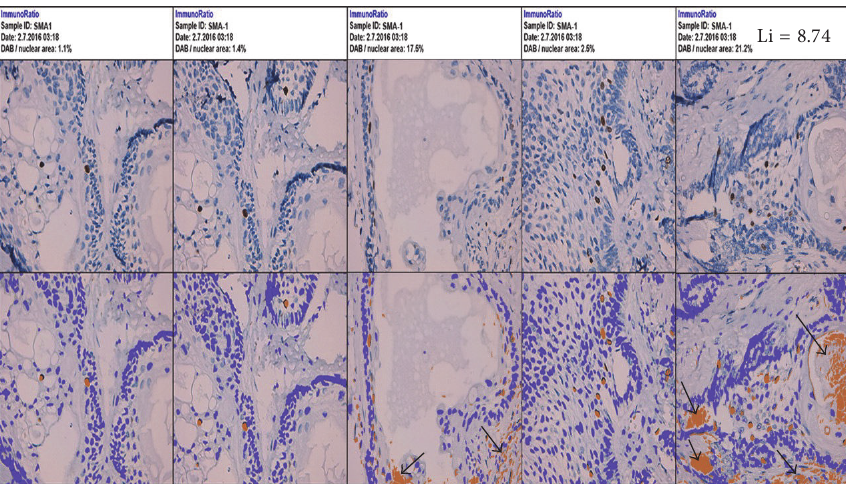
Figure 6: Photomicrographs of a solid ameloblastoma specimen at 400x magnification using the online basic ImmunoRatio method (IRB scoring). Arrowheads indicate the false positive zones in the pictorial